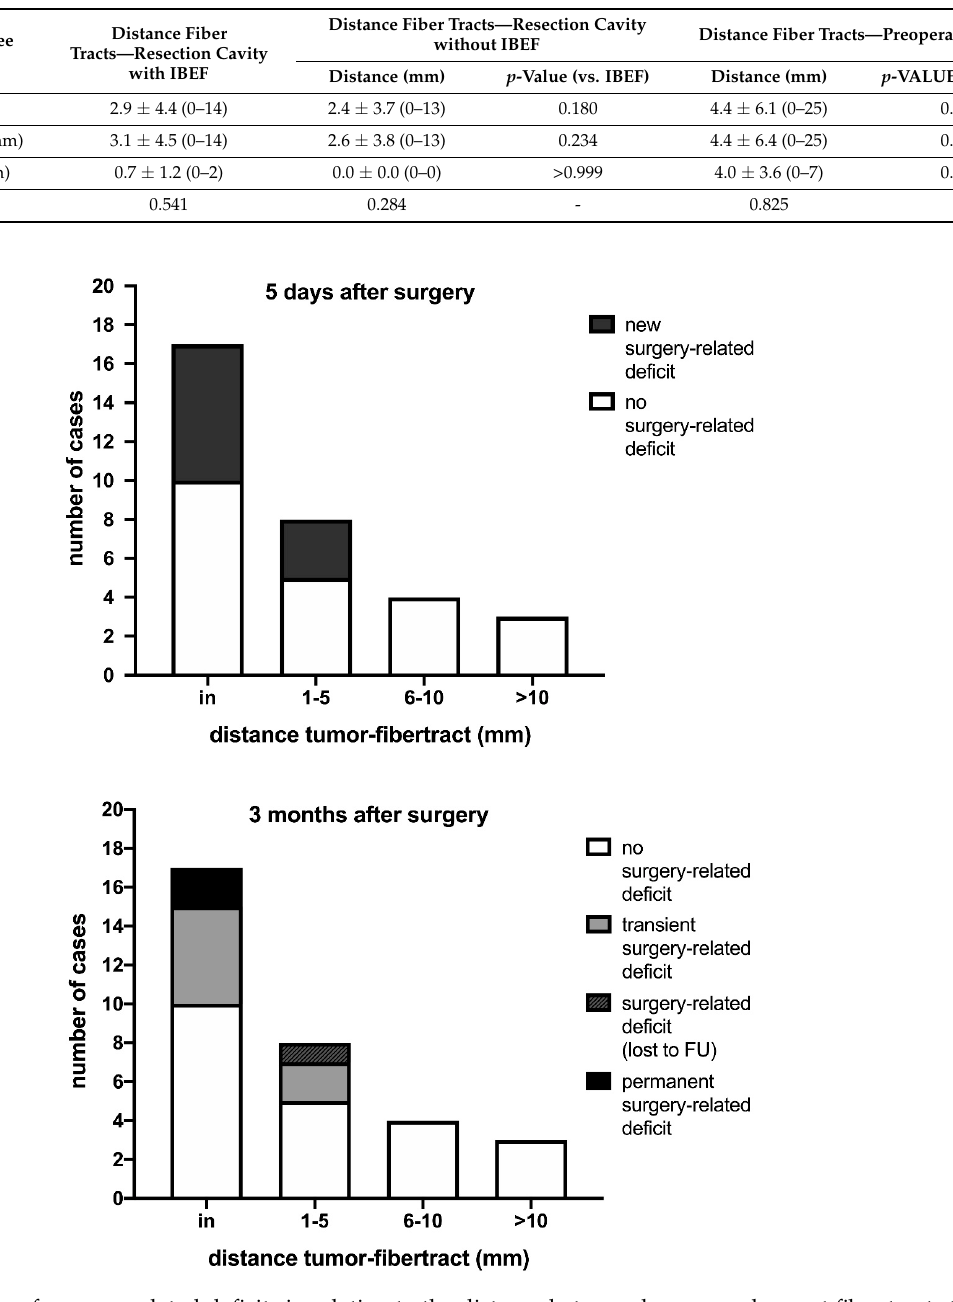
Figure 4. Prevalence of surgery-related deficits in relation to the distance between language eloquent fiber tracts to the intraoperative MRI resection cavity. The surgery-related decrease in language function in relation to the distance between the resection cavity and language eloquent fiber tracts is described in these figures. For a distance greater than 5 mm, no surgery-related deficit was observed. Surgery-related language deficits 5 days postoperatively were lower for distances of 6–10 mm and 10–15 mm ( p = 0.255 and p = 0.521, respectively) compared with patients with language eloquent fiber tracts located in the resection cavity. Similar results were found for permanent surgery-related language deficits, including patients lost to follow-up, for distances of 5–10 mm and 10–15 mm ( p > 0.999 each).